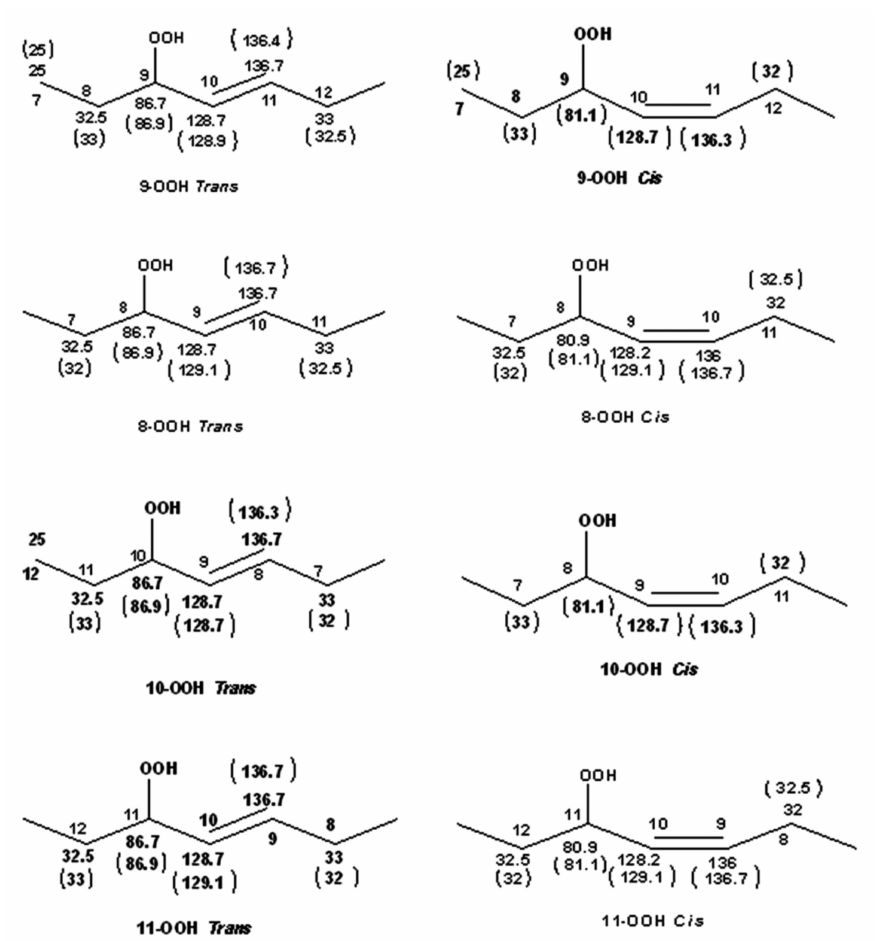
Figure 39. A comparison of the 13 C-NMR chemical-shift data of geometric cis / trans hydroperoxides resulted from oxidation of methyl oleate with those obtained from the literature with the use of chromatographically isolated hydroperoxides (data in parentheses)